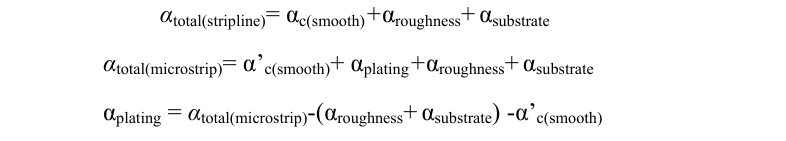
Fig. 6. Measured dielectric parameters on the different types of transmission lines and modes.